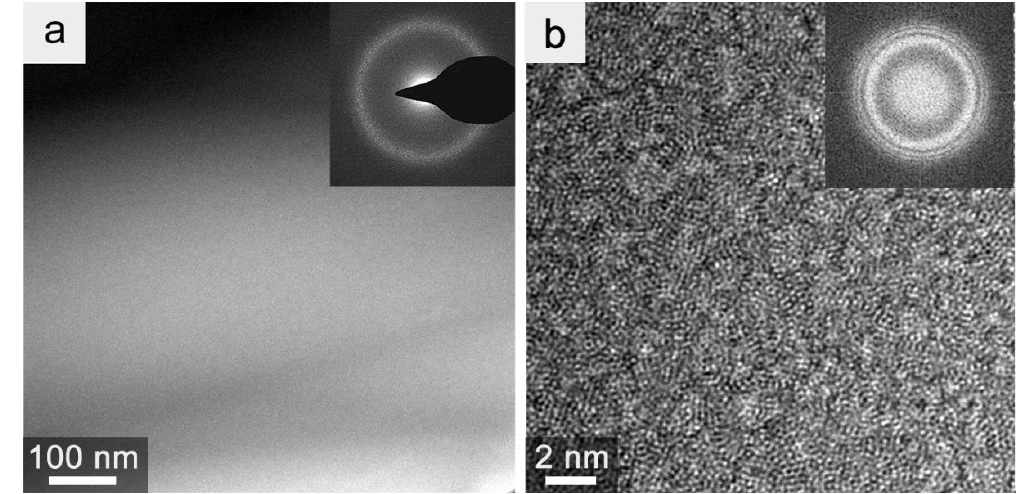
Figure 5. ( a ) TEM micrograph and ( b ) HRTEM image of the ZrCuAlNi strip with insets of the SAED and FFT patterns,